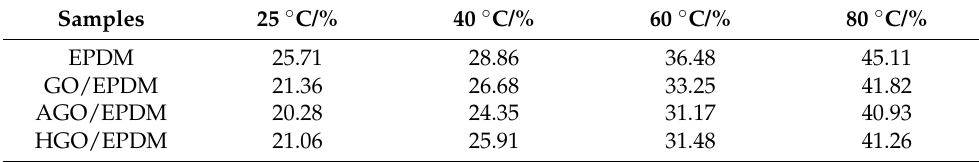
Figure 5. Time-varying concentrations of mixed plasticizers at different temperatures in the insulation: ( a ) 25 °C, ( b ) 40 °C, ( c ) 60 °C, and ( d ) 80 °C. Table 1. Equilibrium concentration of the mixed plasticizers in the insulation.